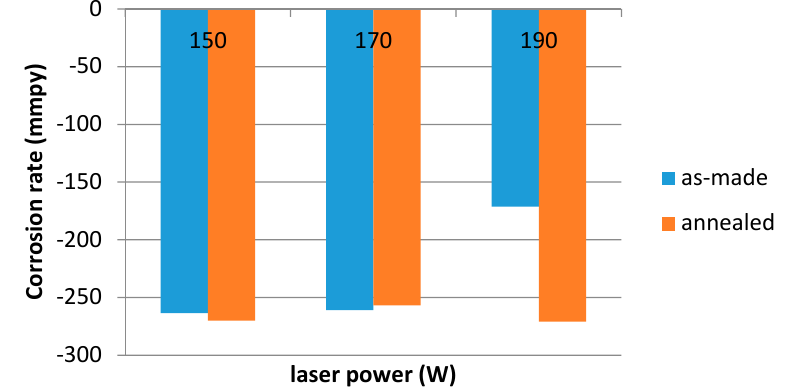
Figure 11. Corrosion potential Ecorr after 144 h exposure in the test solution.